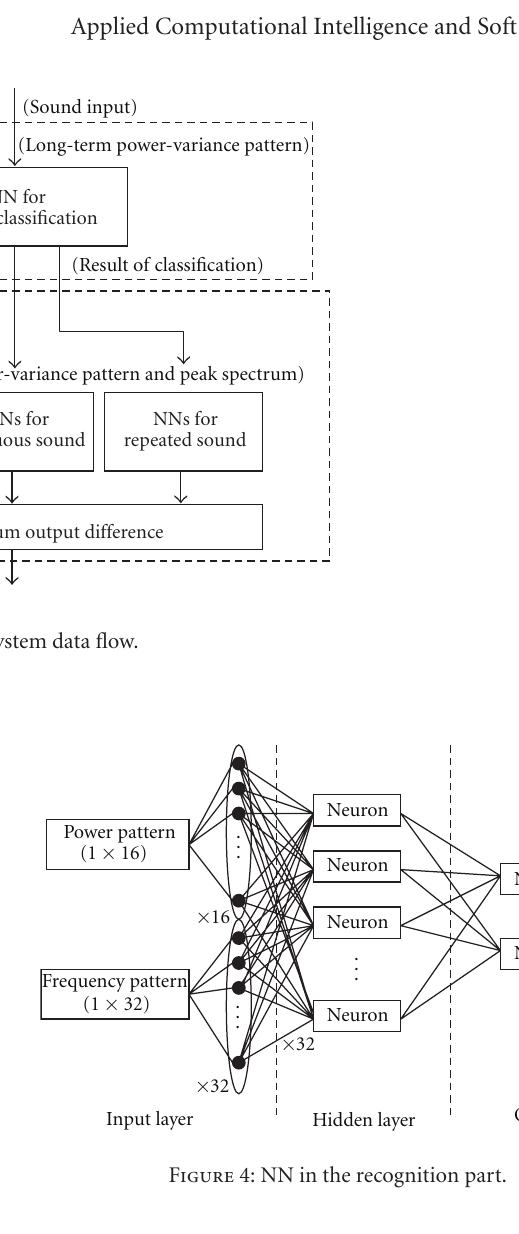
Figure 3: A sample of long-term power-variance pattern (a door- knocking sound).